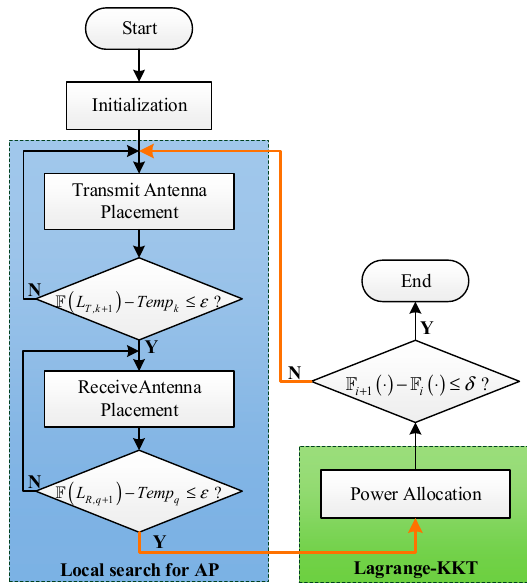
Figure 3. Block diagram of the closed-loop scheme.